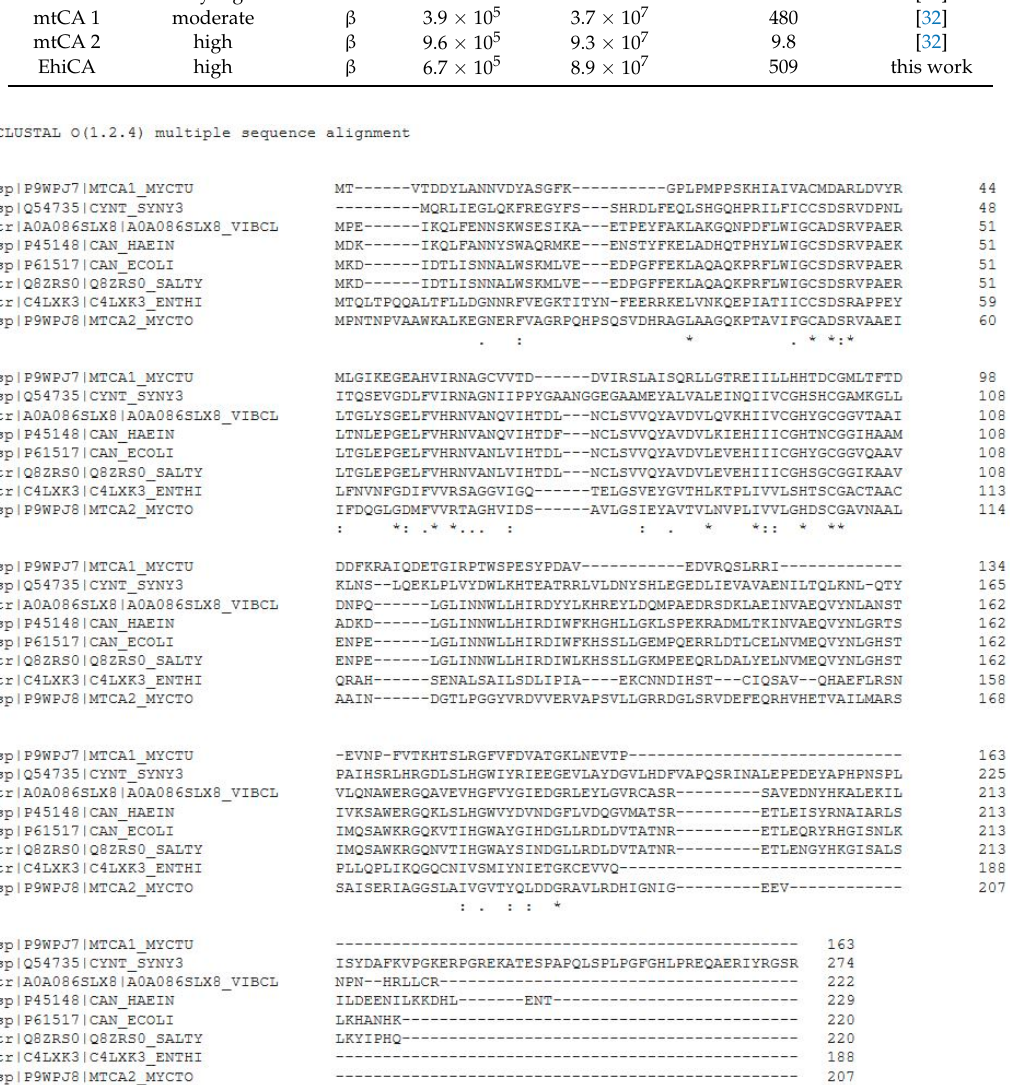
Figure 1. Multi-alignment of the amino acid sequences of the β -CAs from M. tuberculosis (isoform MTCA1_MYCTU), Synechocystis sp. (SYNY3), V. cholerae (VIBCL), H. influenzae (HAEIN), E. coli (ECOLI), S. typhimurium (SALTY), E. histolytica (ENTHI), and M. tuberculosis (isoform MTCA2_MYCTO) [21,30–36]. Conserved amino acids depicted by an asterisk (*), semiconserved ones by (.) or